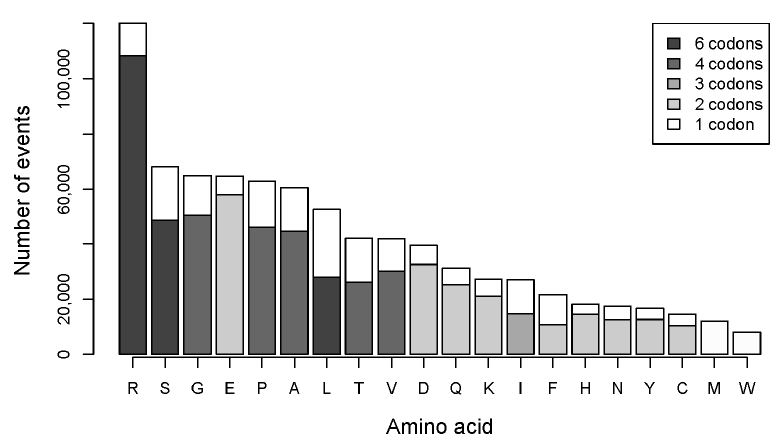
Figure 6. Distribution of coding and silent substitutions in the analyzed proteins for each amino acid in the Catalogue of Somatic Mutations in Cancer (COSMIC) database. The number of silent substitutions is shown in white; the number of coding substitutions is marked according to the number of codons that code for each amino acid.